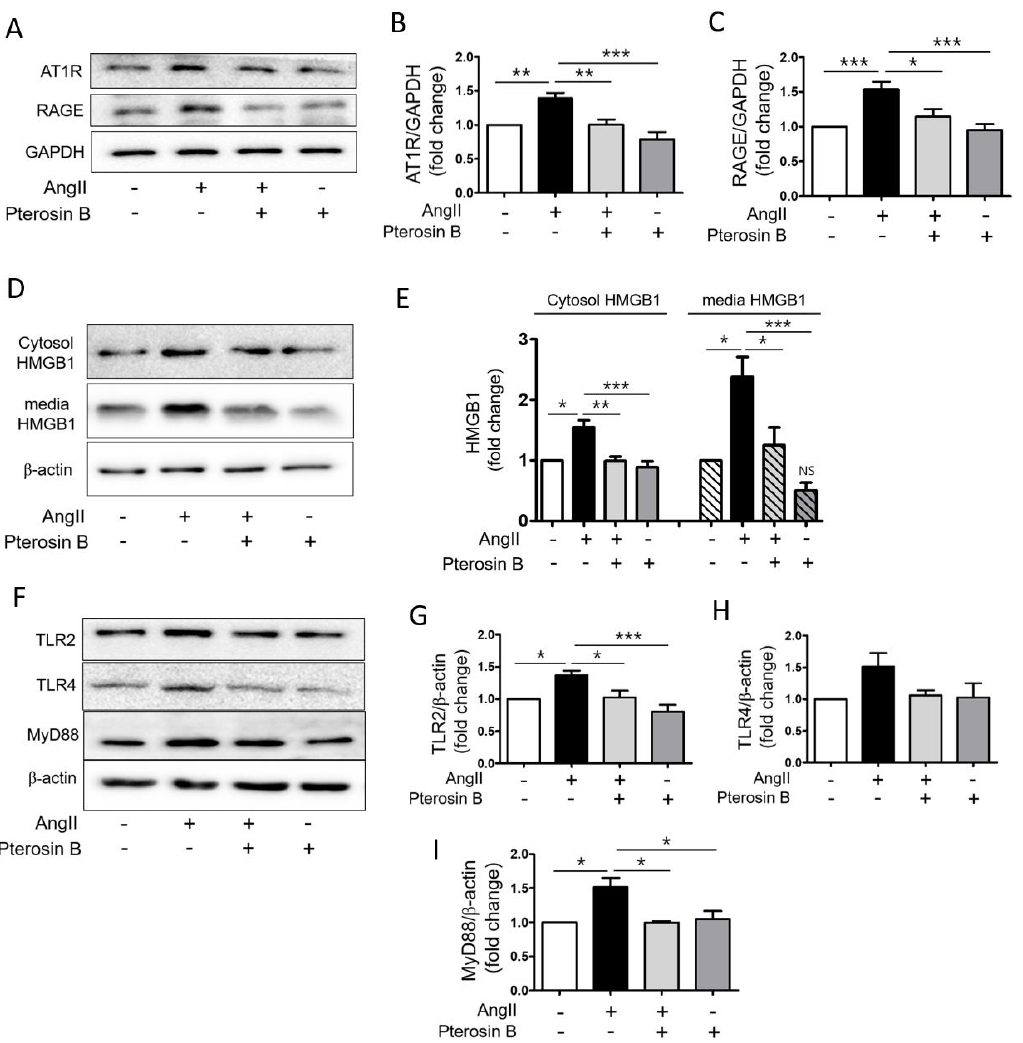
Figure 3. Effects of Pterosin B on Ang II-activated HMGB1 secretion. H9c2 cells were treated with 300 nM Ang II with or without Pterosin B. ( A ) Protein expression levels of AT1R and RAGE in H9c2 cells-treated with 300 nM Ang II with or without Pterosin B for 48 h. ( B , C ) Quantification of AT1R and RAGE expression levels shown in ( A ). The protein levels were normalized to GAPDH. * p < 0.05, ** p < 0.01, *** p < 0.001. n = 6. ( D ) H9c2 cells were treated with Ang II for 10 min and HMGB1 expression level was detected by Western blot from cell lysate and culture medium. ( E ) Quantification of intracellular HMGB1 protein levels and amount of secreted HMGB1 shown in ( D ). * p < 0.05, ** p < 0.01, *** p < 0.001. NS vs. control. n = 4. ( F ) H9c2 cells were treated with Ang II with or without Pterosin B for 48 h. Western blot was performed to detect protein expression levels of TLR2, TLR4, and MyD88.